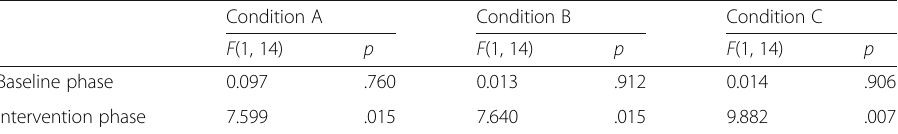
Table 5 Results of one-way ANOVA